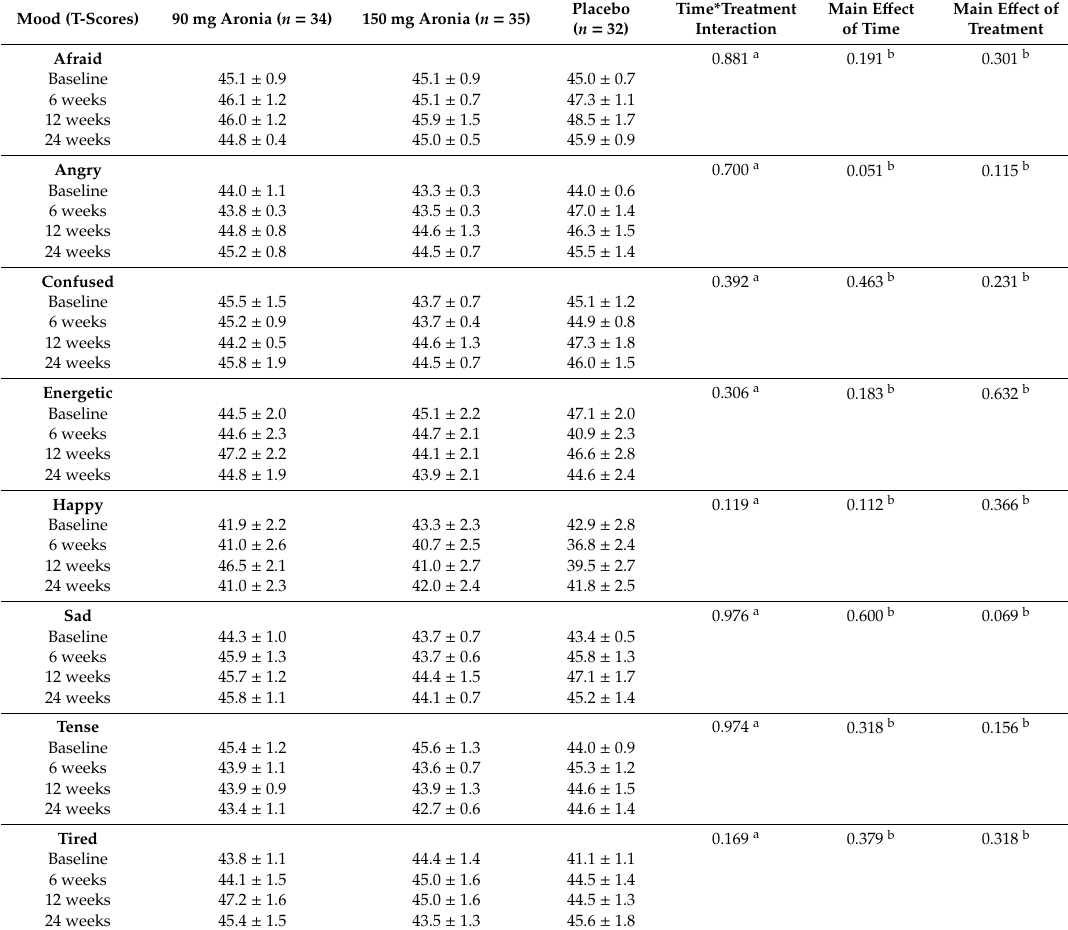
1 Data are presented as actual mean ± SEM. Analysis was performed with a linear mixed model using estimated means, with correction for baseline values. a p -values originate from the linear mixed model with a time*treatment interaction. b p -values originate from the linear mixed model without a time*treatment